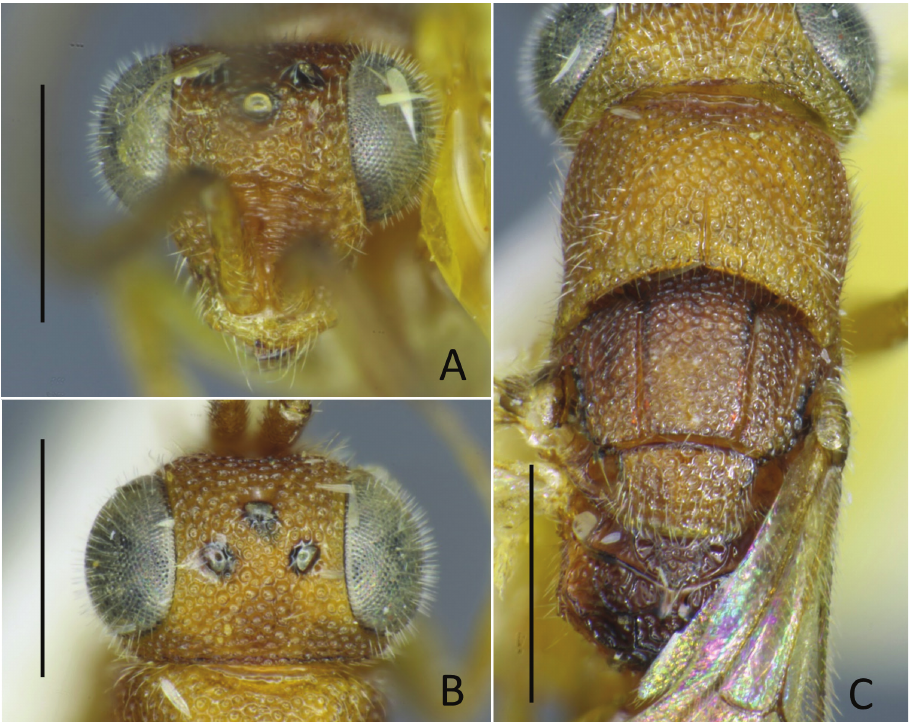
Figure 6. Baeosega torrida Krombein ♂ A head in frontal view, paratype B ditto, dorsal view, allotype C ditto, mesosoma. Scale bars: 0.5